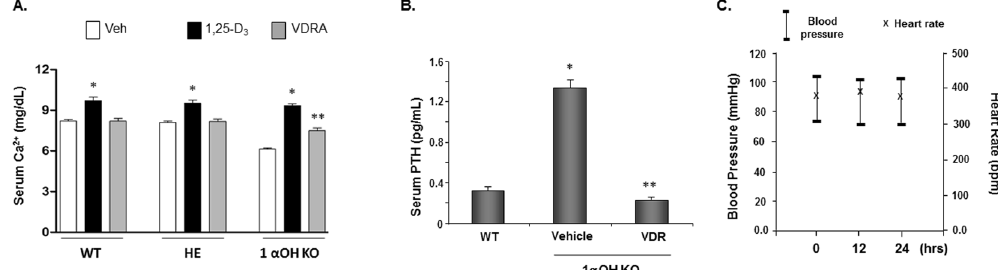
Figure 4. Effect of VDR 4-1 on biochemical and physiological parameters in vivo . ( A,B ) Serum Ca 2 + ( A ) and PTH ( B ) levels after long-term injections (0.6 μ g/kg M, W, F for 1 week). 1,25-D 3 (0.6 μ g/kg), VDR = VDR 4-1 (0.6 μ g/kg) 3 x/week i.p . * p < 0.05 vs Veh, ** p < 0.05 vs 1,25-D 3 ; N = 3/group. WT = wild-type, HE = heterzygote for 1 α -HO deletion (1 α -HO − / + ), 1 ααααα -HO KO = homozygote for 1 α -HO deletion (1 α -HO − / − ). ( C ) BP and HR after VDR 4-1 injection (0.6 μ g/kg i.p .) at different times. N =